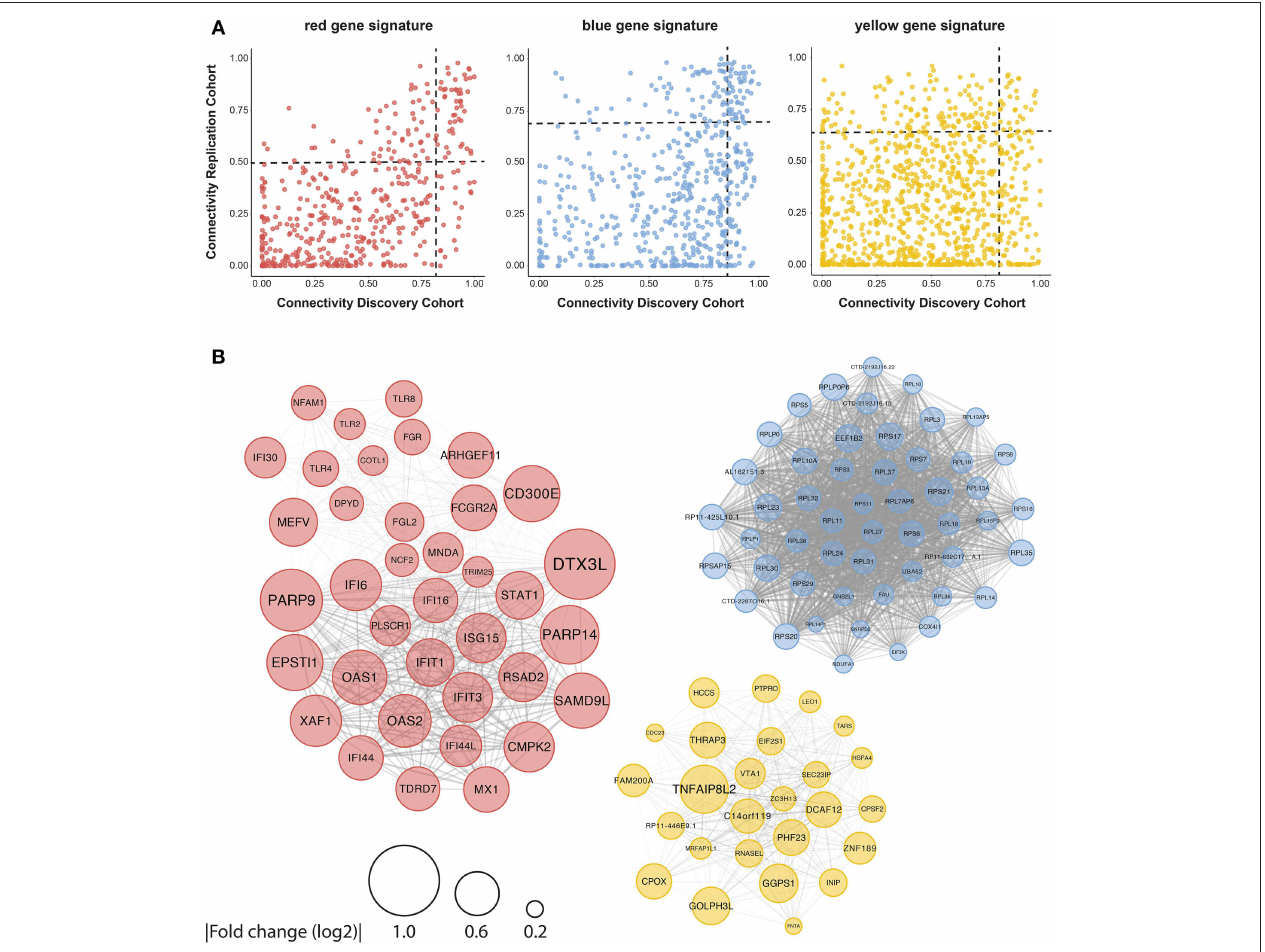
FIGURE 4 | Identification of consistently well-connected hub-genes in identified gene signatures. The connectivity of each gene within the red, blue, and yellow signatures is plotted for both the discovery and replication analysis. For each gene, the connectivity represents the sum of connection strengths with its neighbors in a given module. We normalized the connectivity for each module in the range [0, 1], where 0 represents the minimum and 1 represents the maximum connectivity in the module. Genes with a connectivity above the 75th percentile in both discovery and replication analysis were considered to be hub-genes, the 75th percentile cut-offs for both cohorts are shown with a black dotted line (A) . (B) The hub genes were plotted based on the data from the replication cohort, the width of the edges between the nodes reflects the strength of their correlation and the size of each node shows the mean fold-change in expression between pSS and HC